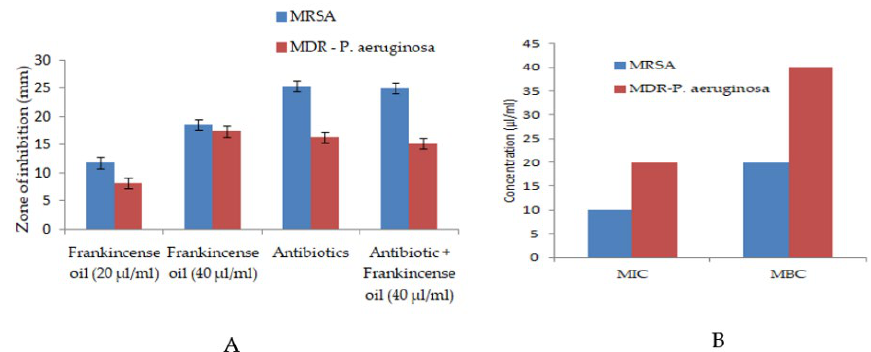
Figure 2. Antibacterial activity of frankincense oil against bacterial pathogens. ( A ) shows zone of inhibition and ( B ) indicates MIC and MBC.